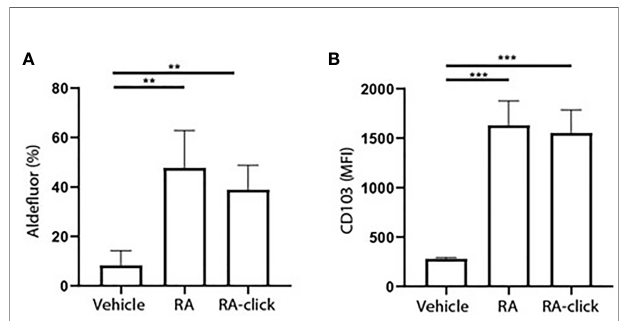
FIGURE 3 | Clickable RA probe induces tolerogenic phenotype in monocyte- derived dendritic cells. Monocytes were isolated from blood and differentiated into monocyte-derived dendritic cells (moDCs) during 7 days of culture in the presence of GM-CSF and IL-4 from 3 different donors. (A) Alde fl uor positivity and (B) CD103 expression in moDCs differentiated in the presence of natural RA or RA click. Data are presented as mean± SD. Student's t test; ANOYA; **p < 0.01, ***p